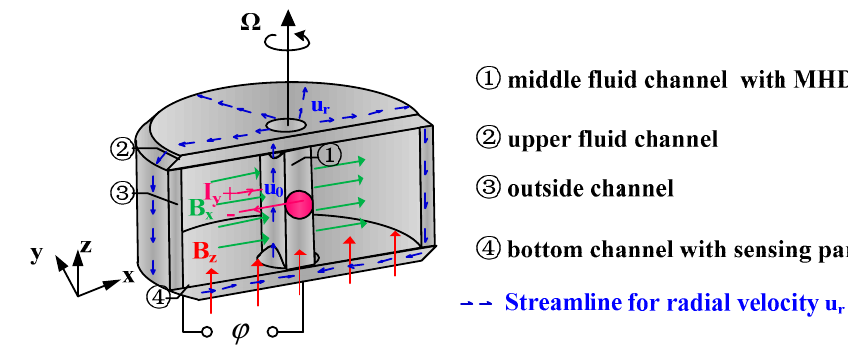
Figure 2. Description of the fluid channel in C-MHD ARS.